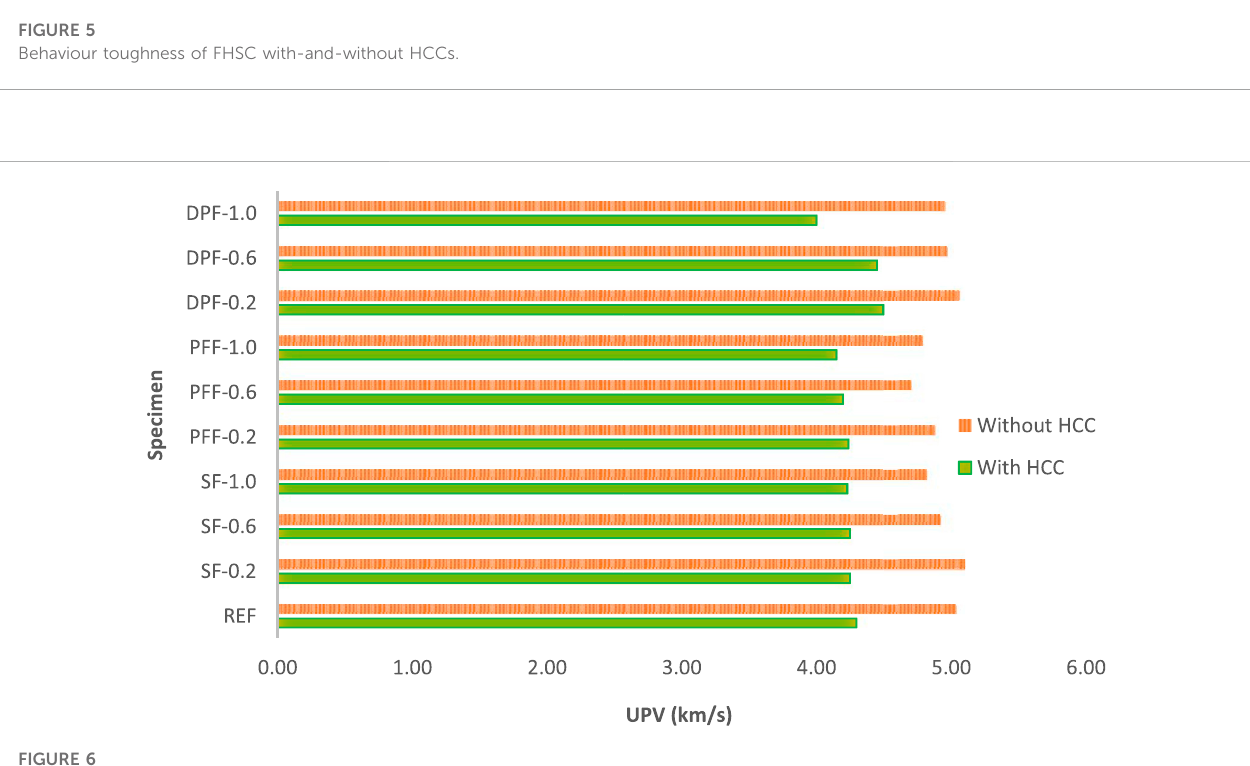
FIGURE 6 Deviations of UPV with and without HCCs for